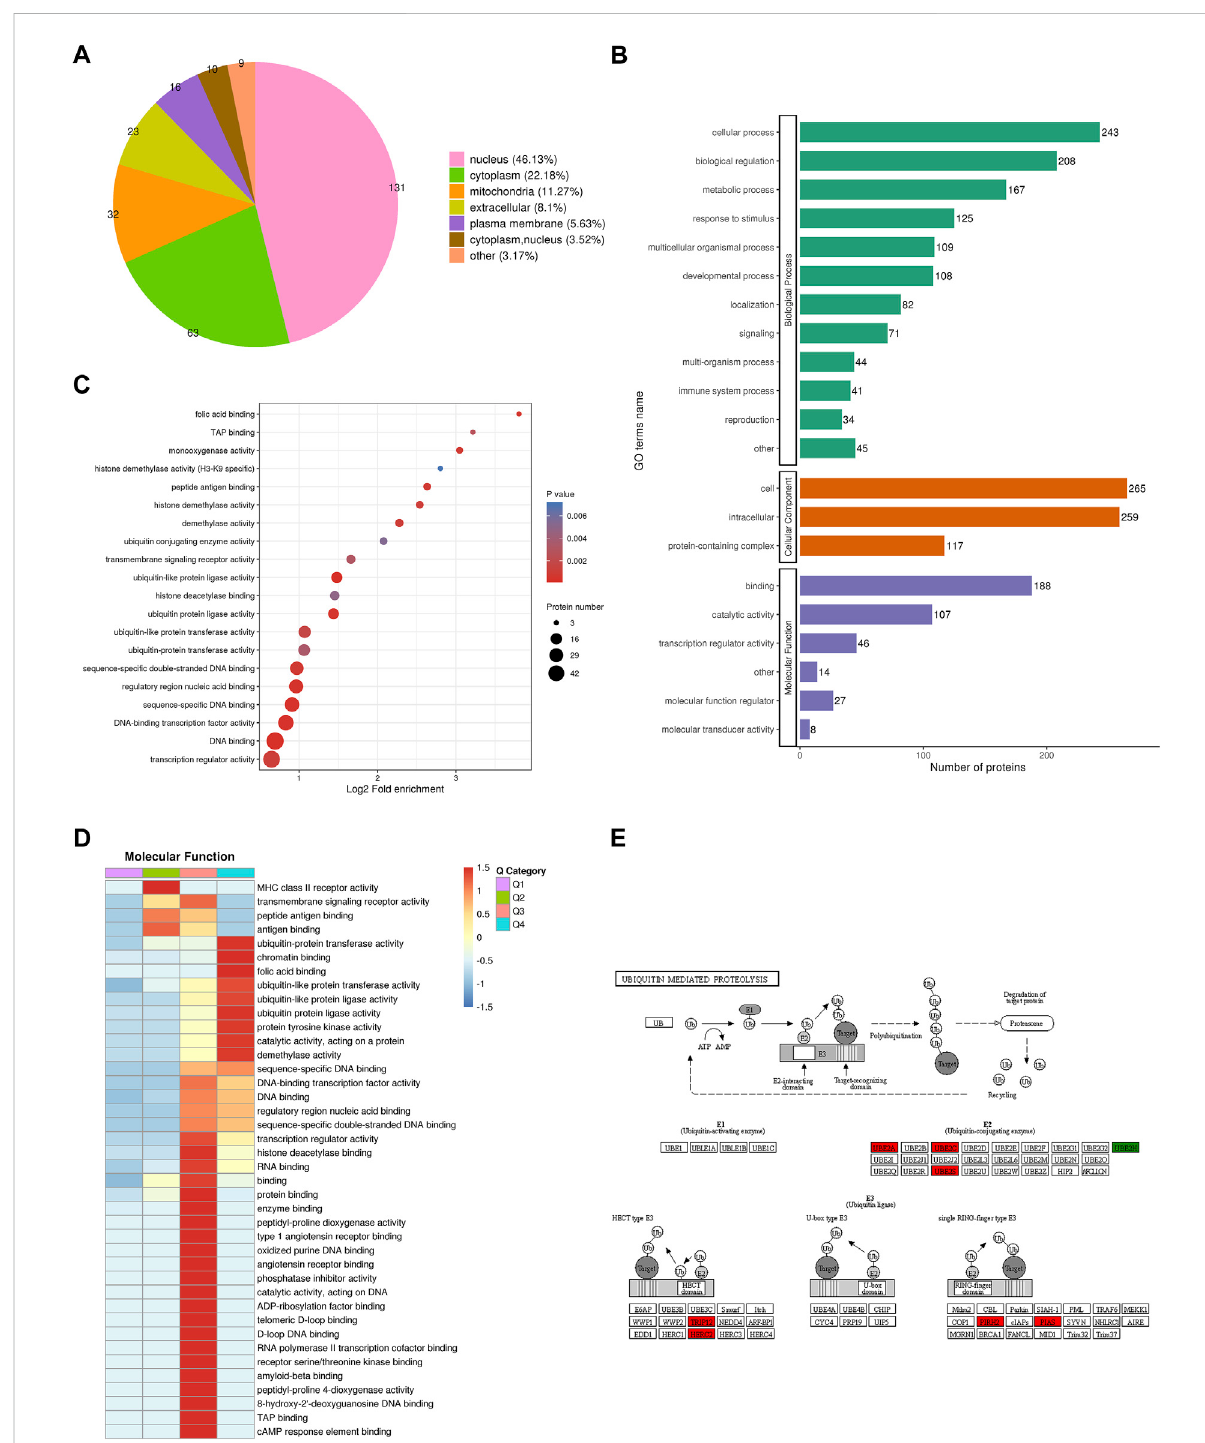
FIGURE 3 Bioinformatics analysis and protein functional annotation. (A) . The subcellular localization of proteins identi fi ed by quantitative proteomics in CENPF-upregulatedDLBCLcells; (B) .GeneOntology(GO)-basedenrichmentanalysisofproteinswithsigni fi cantlychangedexpressionlevels; (C,D) . The GO analysis and COG/KOG functional classi fi cation of proteins in the proteome; (E) . The signi fi cantly increased proteins in ubiquitin-mediated proteolysis, including UBE2A, UBE2C, UBE2S, TRIP12, HERC2, PIRH2 and